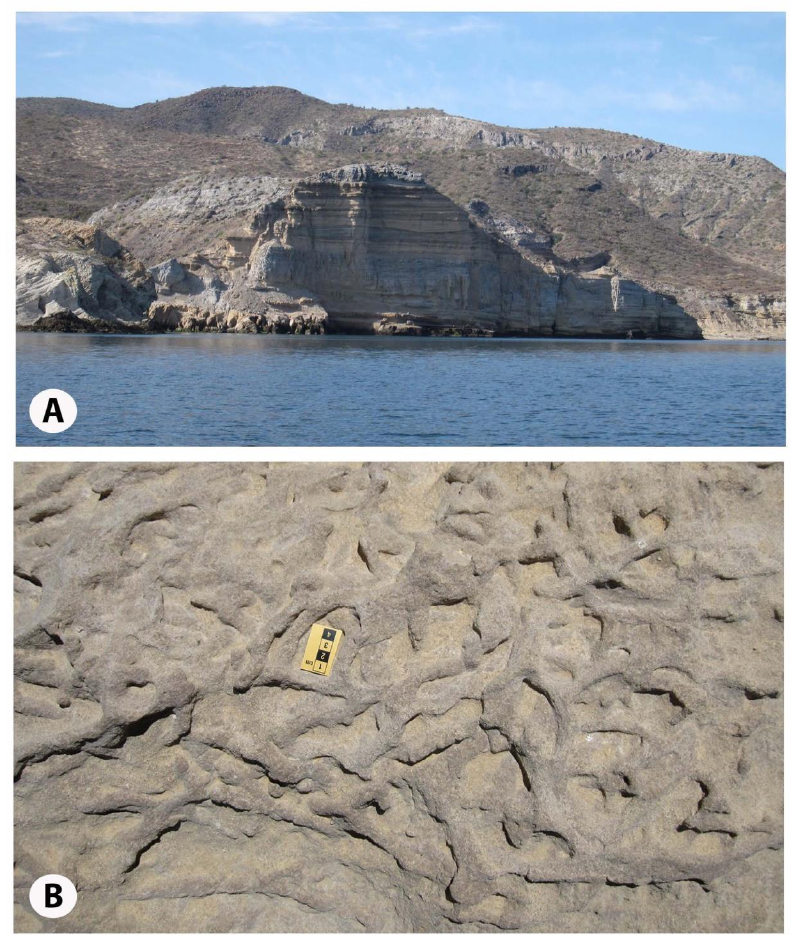
Figure 6. Coastal outcrops west of Punta Mencenares: ( A ) Thirty-meter cliff face formed by interbedded siltstone and sandstone with pockets of secondary gypsum, ( B ) Exposed bedding plane with trace fossils ( Thalassinoides ) preserved in sandstone.